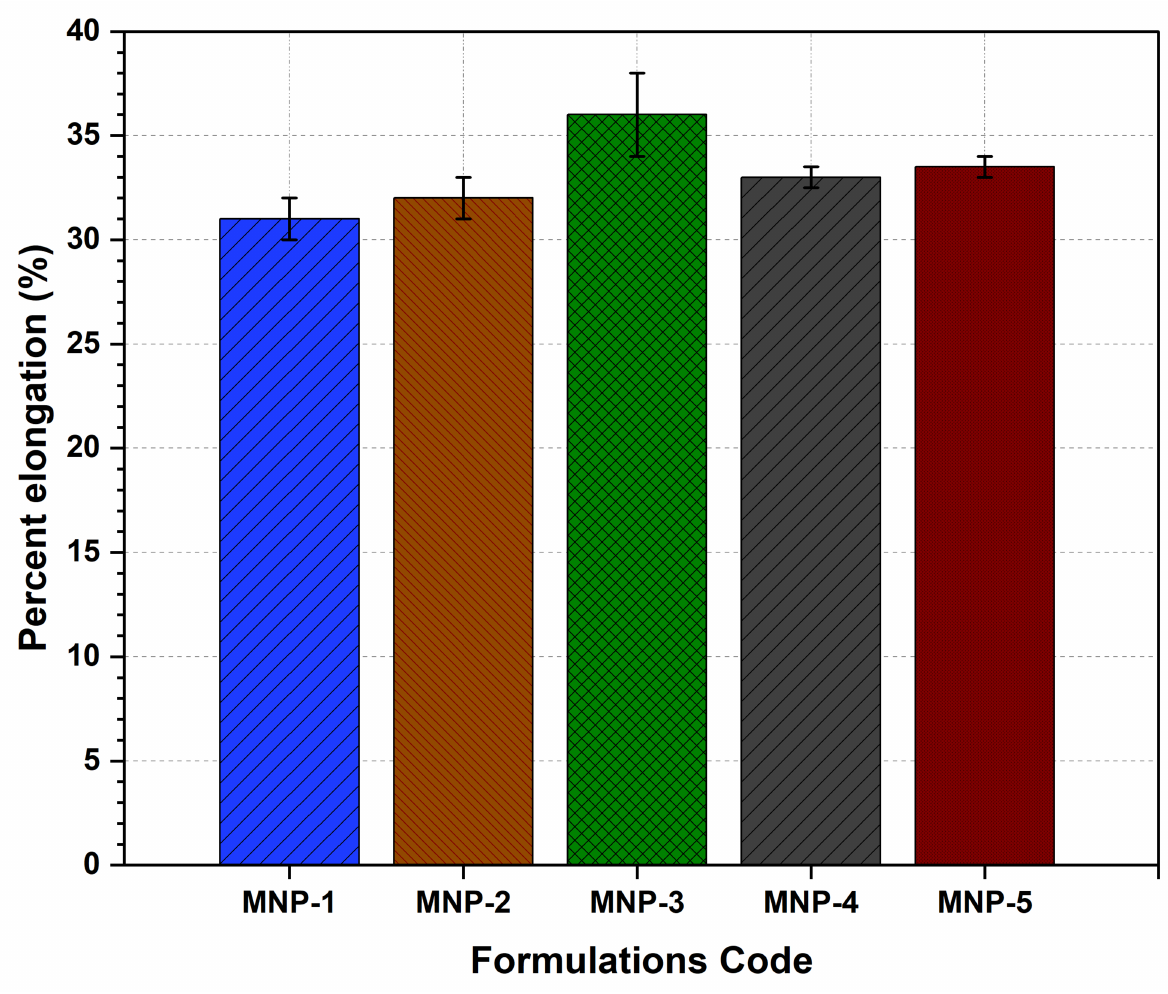
Figure 11. Evaluation of percentage elongation of five different formulations of LS-TC-MNP fabri- cated by different concentrations of thiolated